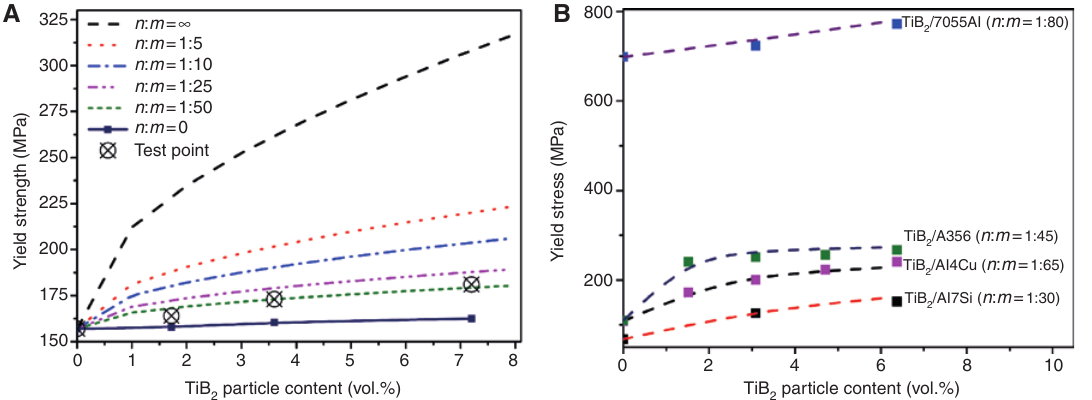
/Al alloy composites. (A) in this 2